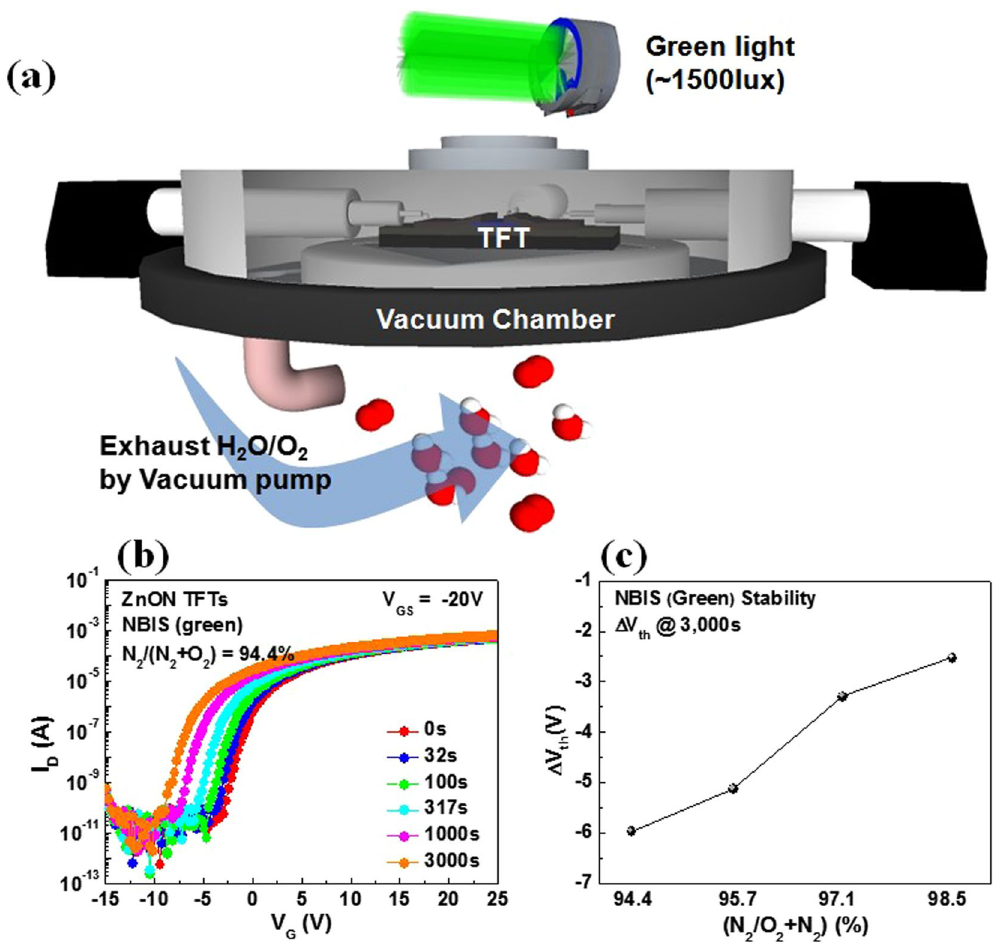
Figure 4. ( a ) Experimental setup for the measurement of ZnON TFT characteristics and stability, using a vacuum chamber and a green light source on top of the entire compartment. ( b ) Transfer characteristics under NBIS of a TFT based on ZnON grown with N 2 /(N 2 + O 2 ) = 94.4%. ( c ) V th shift ( Δ V th ) under NBIS of the ZnON TFTs with respect to the N 2 /(O 2 + N 2 ) gas flow rate ratio used during ZnON